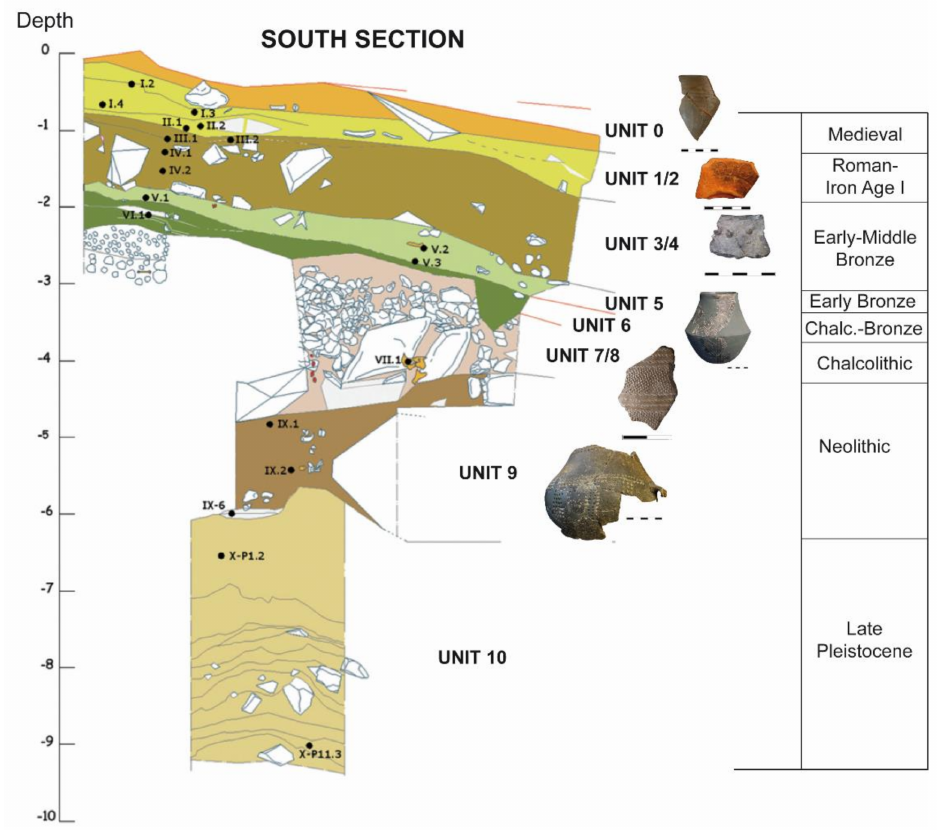
Figure 2. Stratigraphy of El Portal ó n de Cueva Mayor archaeological site (south profile). Chalcolithic units 7 and 8 represent a Pre-Bell-Beaker funerary context (stone tumulus) (unit 8) and a late Pre-Bell-Beaker and Bell-Beaker stabling/habitational context (unit